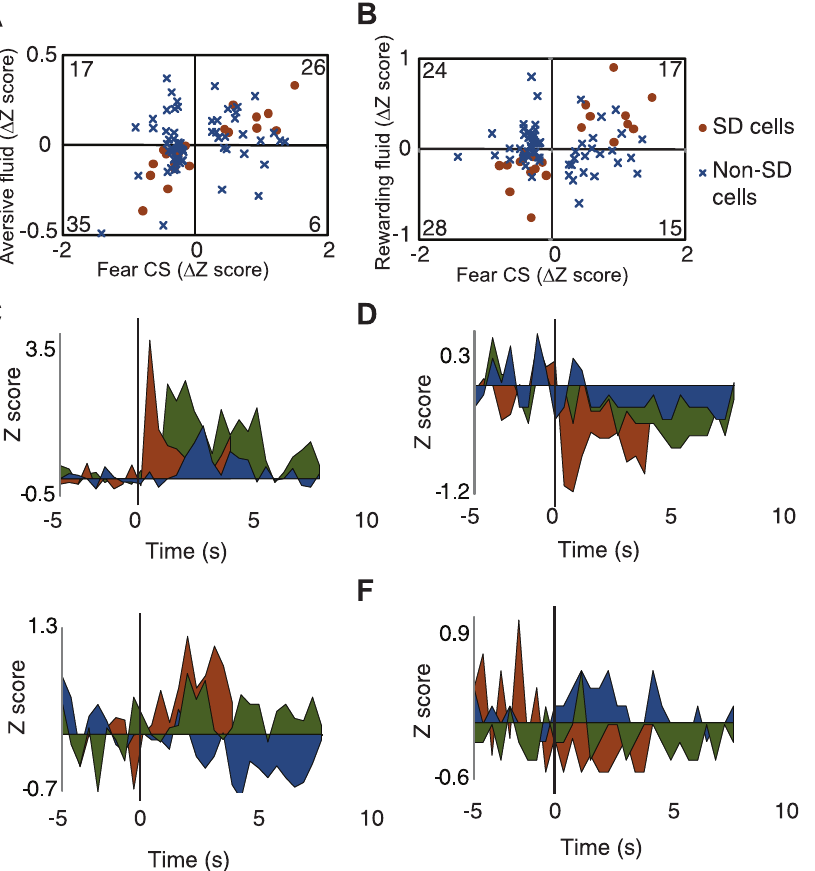
Figure 4. Population plots and examples of SD and non-SD cells. ( A ) Population plot of changes in neuronal activity during the fear CS and aversive fluid infusion. ( B ) Population plot of changes in neuronal activity during the fear CS and rewarding fluid infusion. ( C )–( F ) depict average activity to each of the stimuli for one cell. Red is fear CS, blue is rewarding fluid infusion, and green is aversive fluid infusion. ( C ) Example perievent time histogram of an SD cell which had an increase in activity during the fear CS. Mean and standard deviation of firing rates for baseline periods before fear CS, rewarding fluid infusion, and aversive fluid infusion, respectively: 2.0 6 2.3; 2.0 6 2.1; 1.6 6 1.7; ( D ) Example perievent time histogram of an SD cell which had a decrease in activity during the fear CS. Mean and standard deviation of firing rates for baseline periods before fear CS, rewarding fluid infusion, and aversive fluid infusion, respectively: 2.1 6 1.5; 0.3 6 0.7; 0.5 6 0.6; ( E ) Example perievent time histogram of a non-SD cell which had an increase in activity during the fear CS. Mean and standard deviation of firing rates for baseline periods before fear CS, rewarding fluid infusion, and aversive fluid infusion, respectively: 7.4 6 3.3; 5.7 6 3.5; 5.7 6 2.8; ( F ) Example of a non-SD cell which had a decrease in activity during the fear CS. Mean and standard deviation of firing rates for baseline periods before fear CS, rewarding fluid infusion, and aversive fluid